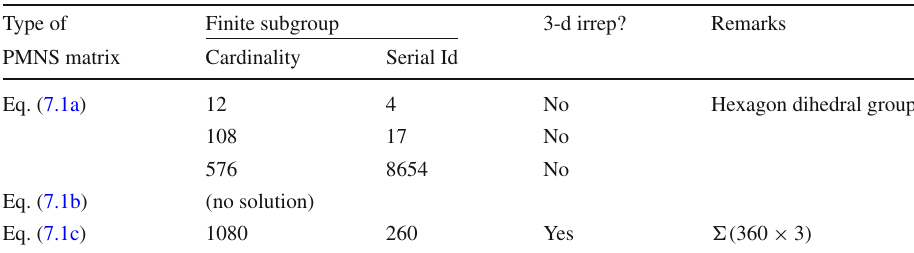
Table 4 Result of the search described in the text. For each kind of PMNS matrix elements, we give the possible finite subgroup of a Coxeter group. The numbers given under the columns marked “cardinality” and “serial Id”, taken together, internet archives